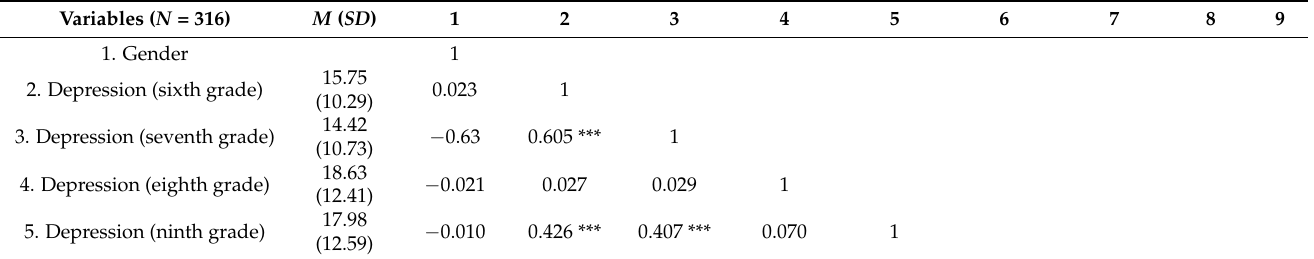
Table 1. Mean levels and bivariate correlations among main study variables 1